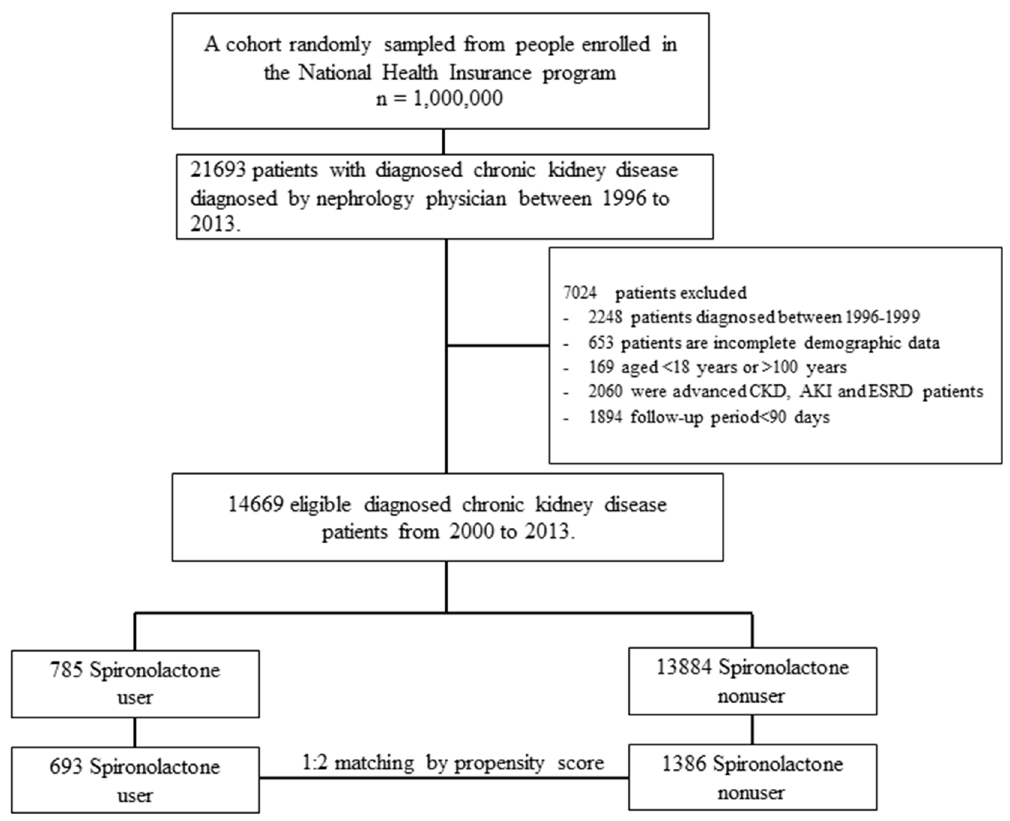
Figure 1. Flowchart of patient selection processes for stage 3–4 chronic kidney disease CKD with or without spironolactone use.